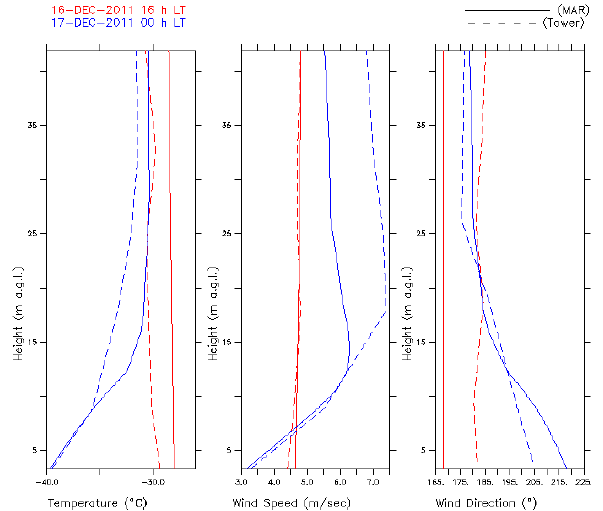
Figure 3. Vertical profiles of simulated temperatures, wind speeds and wind directions on 16 December 2011 at 16:00LT and mid- night.